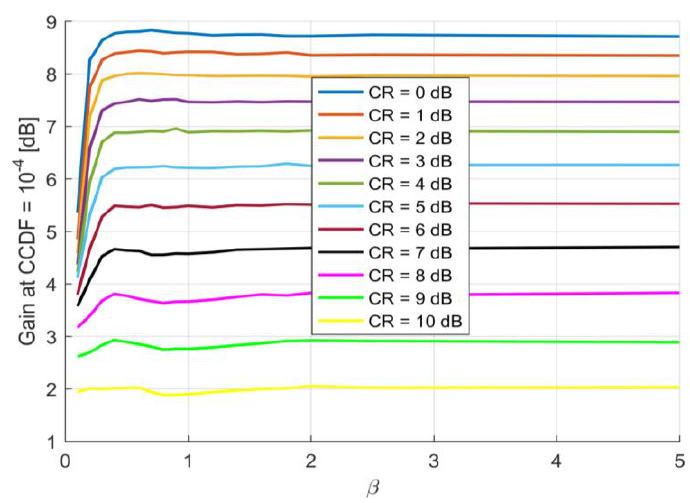
Figure 9. Palm Clipping (PC)-OFDM 4-QAM with variable Clipping Ratio (CR) and smoothness.